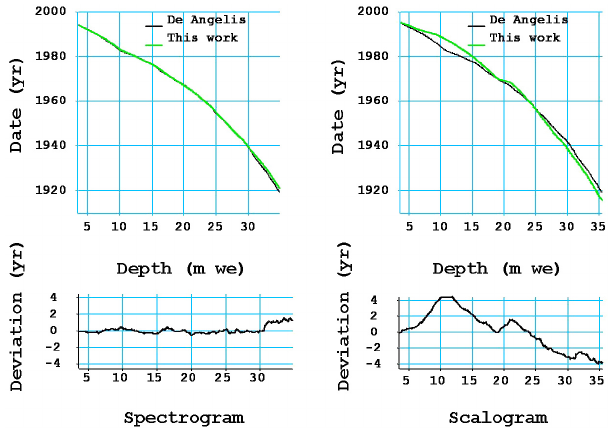
Figure 11. Comparison between the chronology established by de Angelis et al. (2003) and chronologies proposed in this article using S with the spectrogram (left) and the scalogram NO − 3